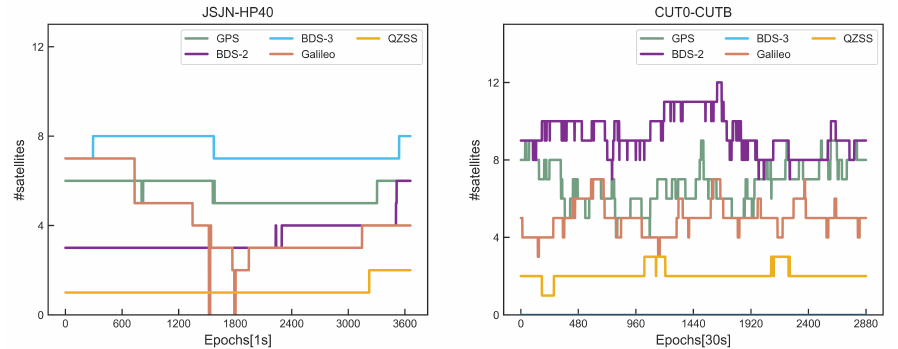
Figure 2. Total number of tracked GPS/BDS-2/BDS-3/Galileo/QZSS satellites for the two static baselines